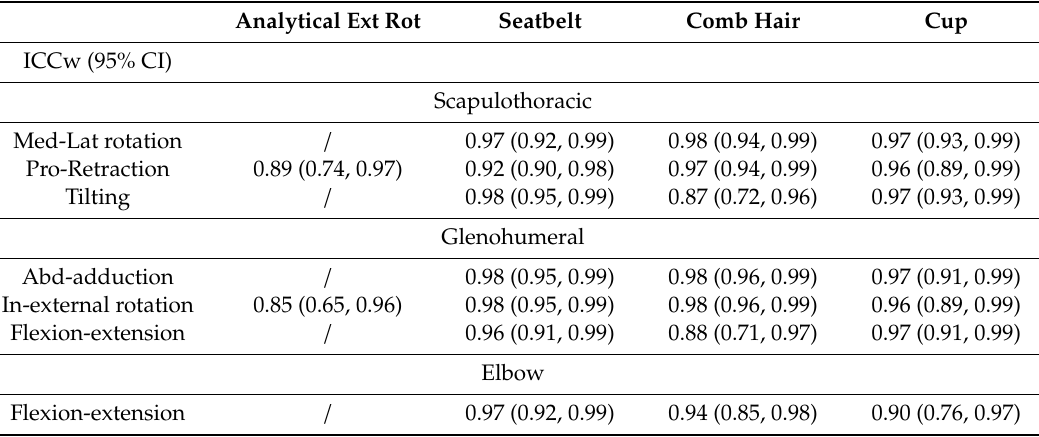
Table 4. Intraclass correlation coe ffi cients for within-session reliability.